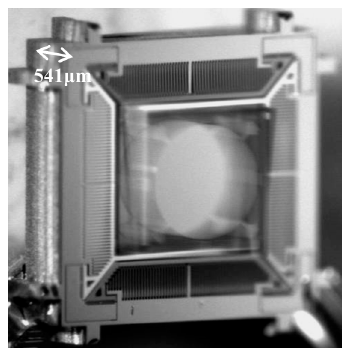
Figure 7. Blur motion image of the scanner in out-of-plane translational resonant mode.